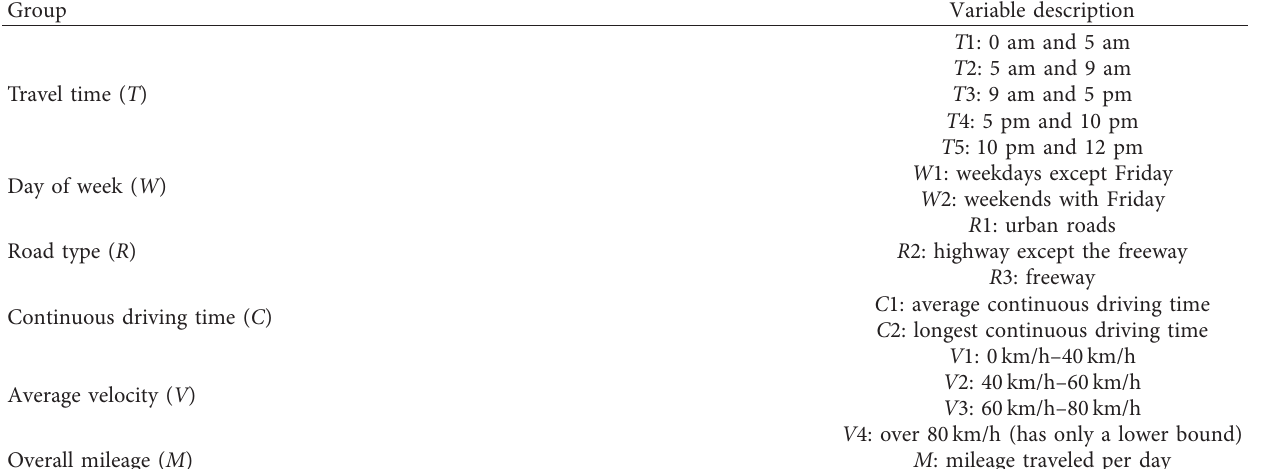
Table 1: Predictor variables.